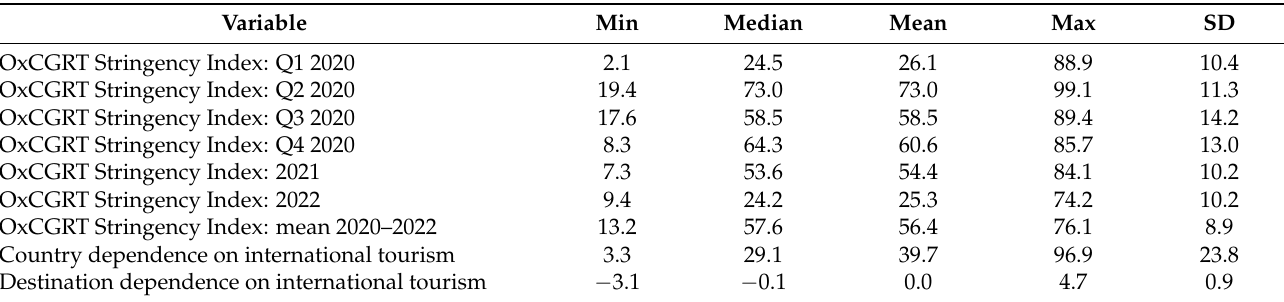
Table 5. Descriptive statistics of controlling variables.